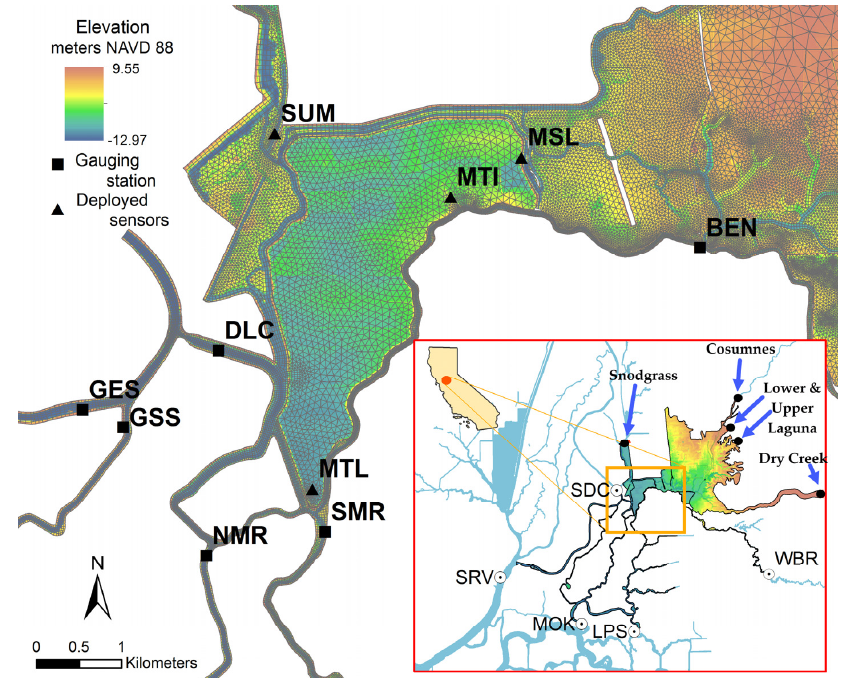
Figure 1. Study area with calibration gage stations shown as black points. Sensors deployed specifically for this study are triangles, and agency gages (either United States Geological Survey (USGS) or the California Department of Water Resources (DWR)) are squares. The model domain is shown (bottom right, location shown as red dot in California) overlying the Delta waterways in blue. Boundary gages are shown in the bottom right figure with agency gages shown as white and black icons and estimated boundaries labeled with blue arrows.